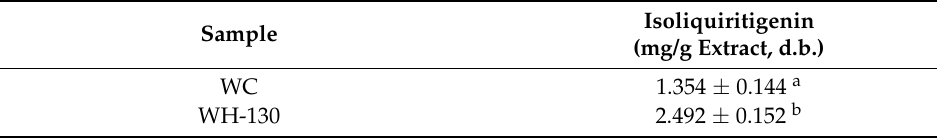
Table 2. Content of isoliquiritigenin in licorice extracts.